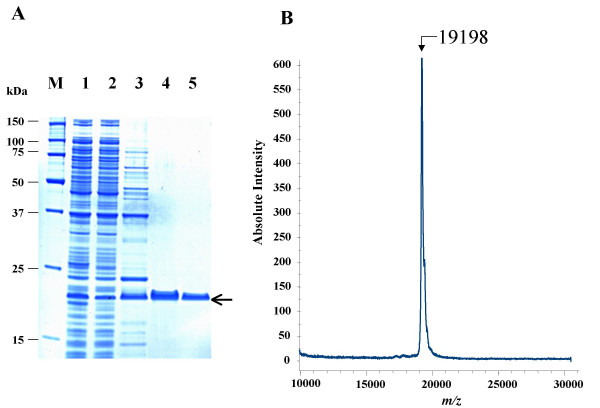
Analysis of untagged SSO0551 purification. A – Various purification steps followed by SDS-PAGE. SDS-PAGE was performed on a 4–12% gradient Novex bis-tris acrylamide gel (Invitrogen) and stained with BlueSafe Coomassie solution (Biorad). Lane M, molecular weight markers; Lane 1, cell-free extract of E. coli Rosetta(DE3)(pLysS)(pSBTN-AB30) ; Lane 2, soluble proteins from cell-free extract; Lane 3, soluble proteins after the 60°C heat treatment; Lane 4, Resource-S eluate ; Lane 5, Superdex75 eluate. Bands corresponding to recombinant SSO0551 polypeptide are indicated with the arrow. B – SSO0551 mass measurement by MALDI-TOF mass spectrometry. Measurements from 250 laser shots of purified protein cristallized with sinapinic acid were averaged.